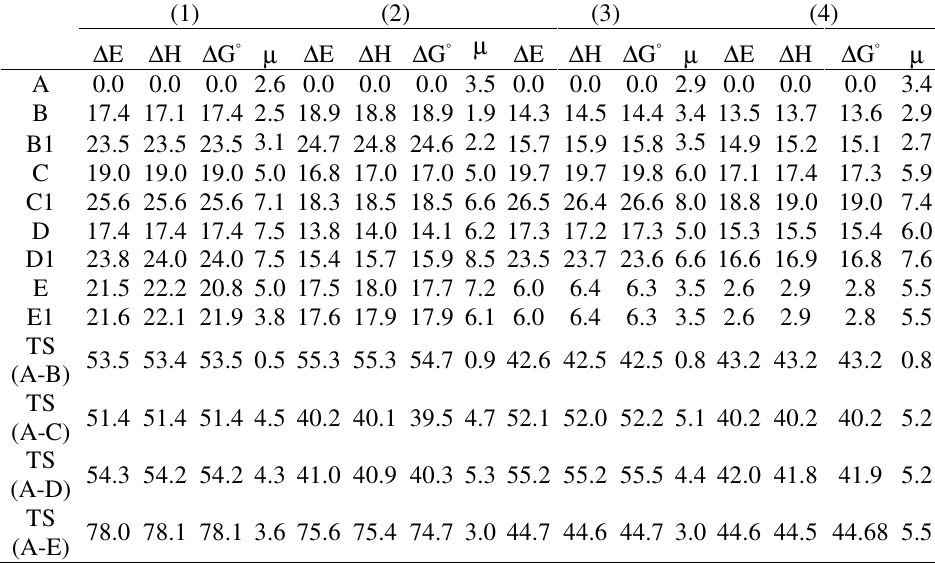
Table 1 . Relative energies (kcal/mol), Enthalpies (298 K, kcal/mol), Gibbs free energies (298 K, kcal/mol), and Dipole moments (in Debye) for the different 5-methyl-2,4-oxo/thio- imidazolidine compounds